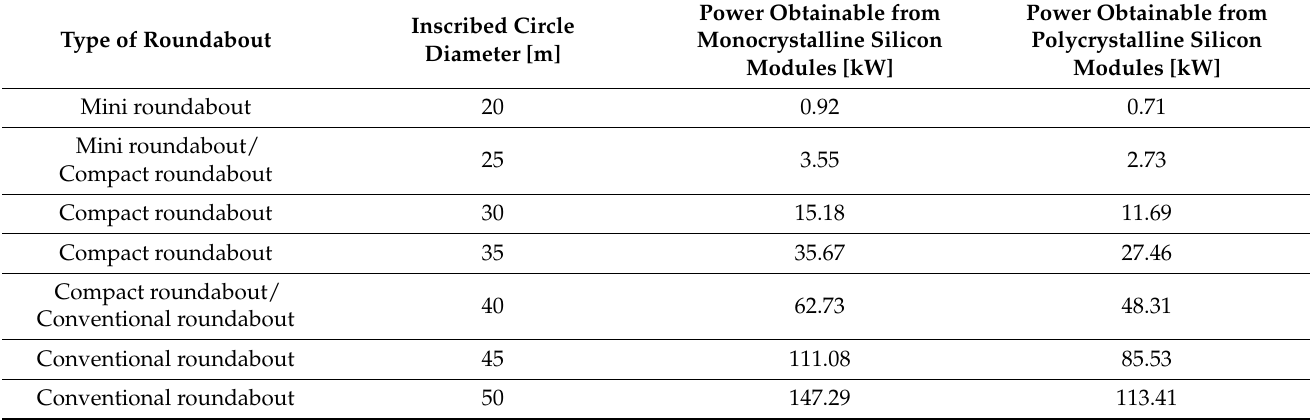
Table 4. Power supplied by the photovoltaic modules.